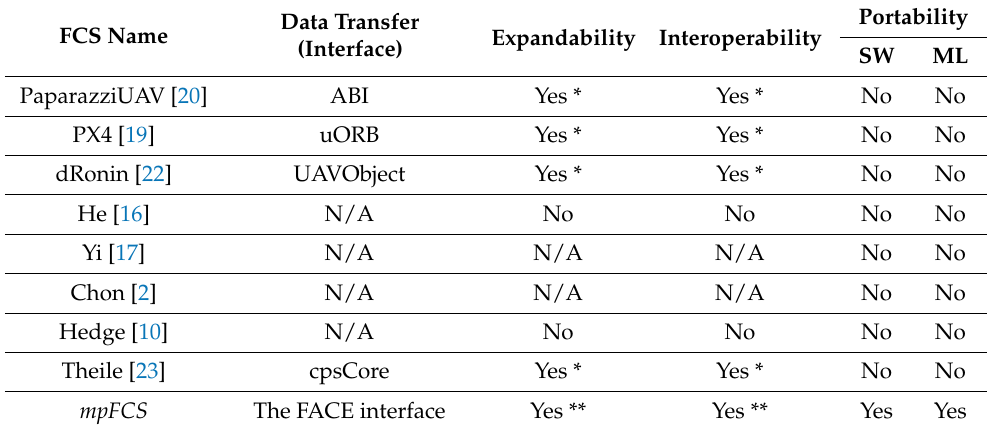
Table 10. Comparison of the existing FCS and the mpFCS